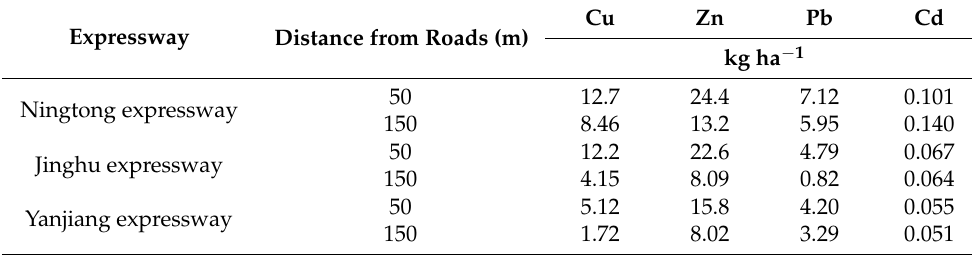
Table 3. Accumulation amount of heavy metals in soil profiles in vicinity of